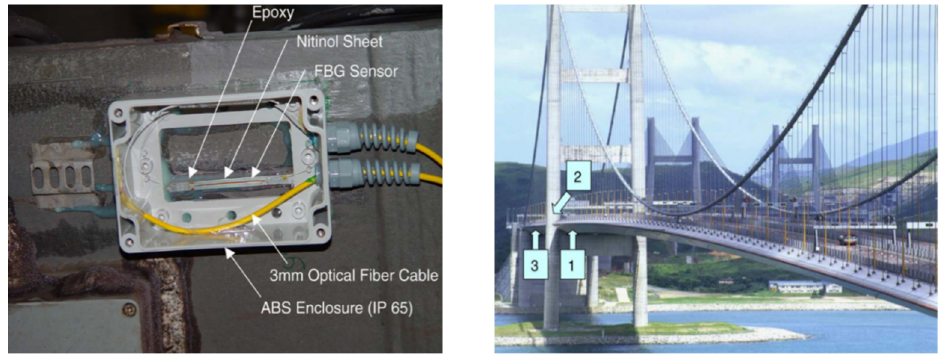
Figure 14. FBG strain gauge sensor on Tsing Ma bridge [169].